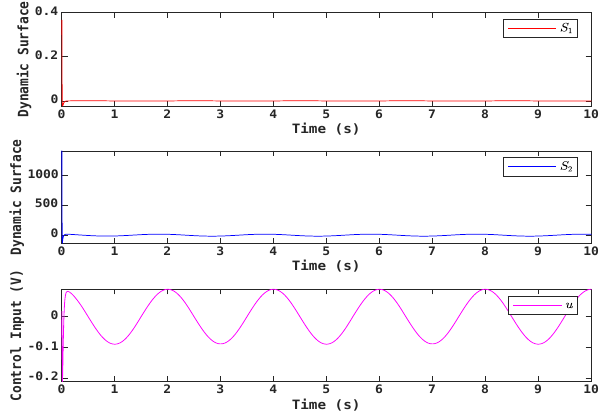
Figure 4. Dynamic surfaces and control input of the proposed control